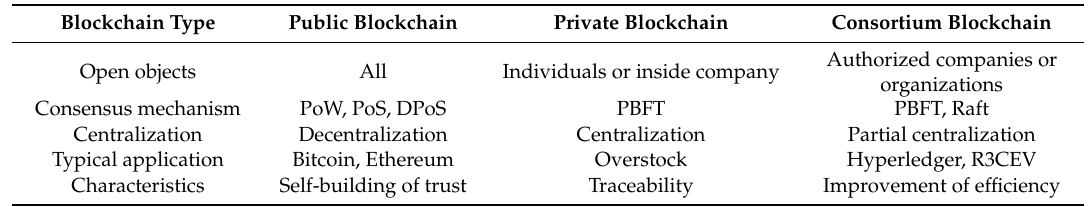
Table 1. The comparison of three types of